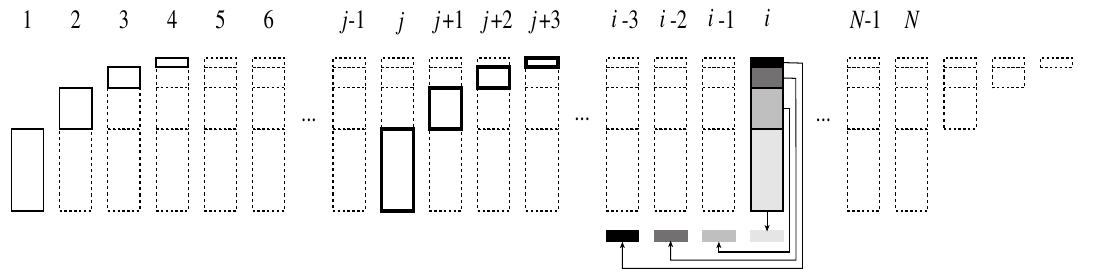
Figure 4. Assignments of processors and data blocks as a function of